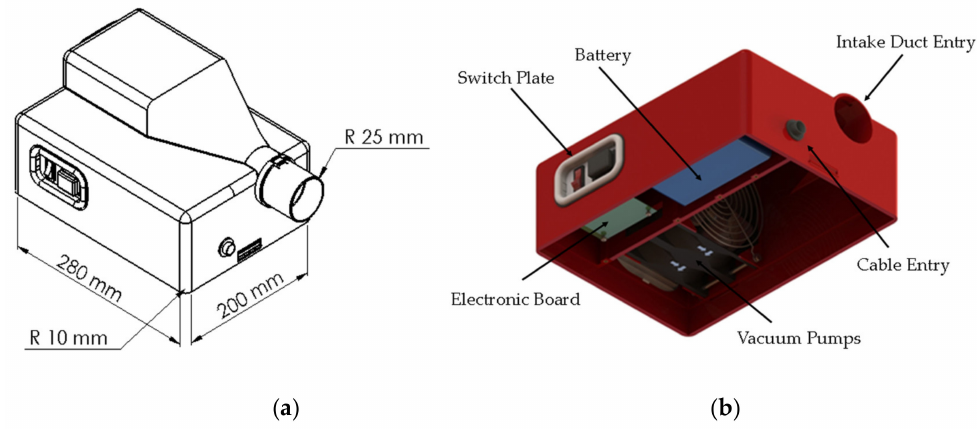
Figure 5. Suction system headboard architecture: ( a ) main sizes; ( b ) internal part assembly description.